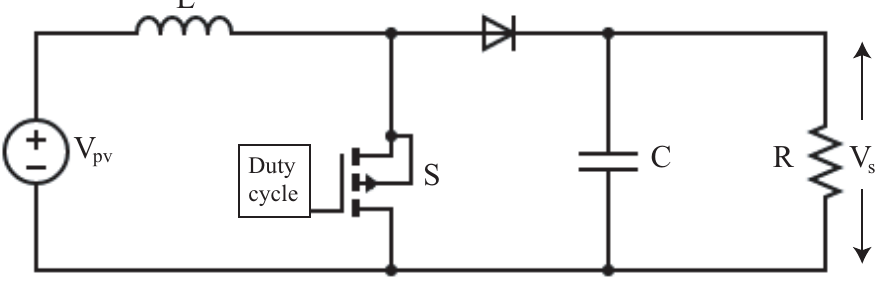
Figure 2. Boost converter